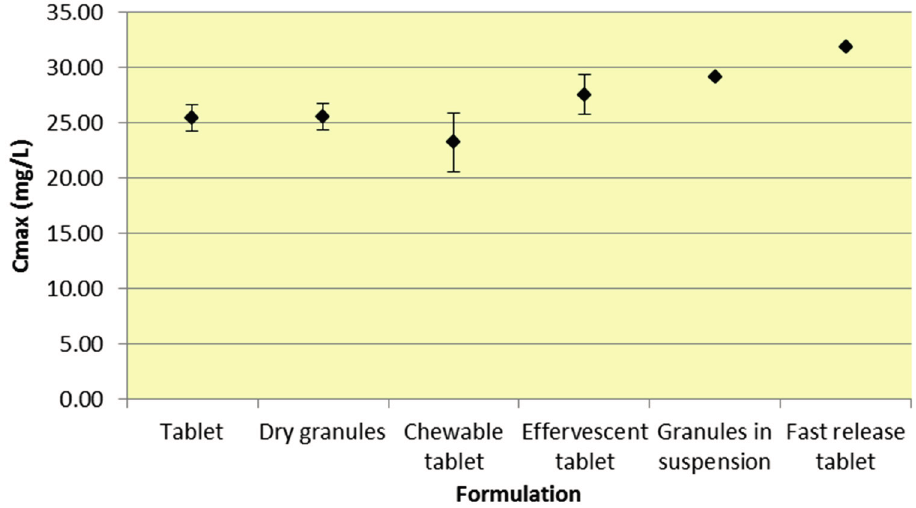
Figure 3. Summary ASA C max for various 500 mg formulations (Mean ± SD).